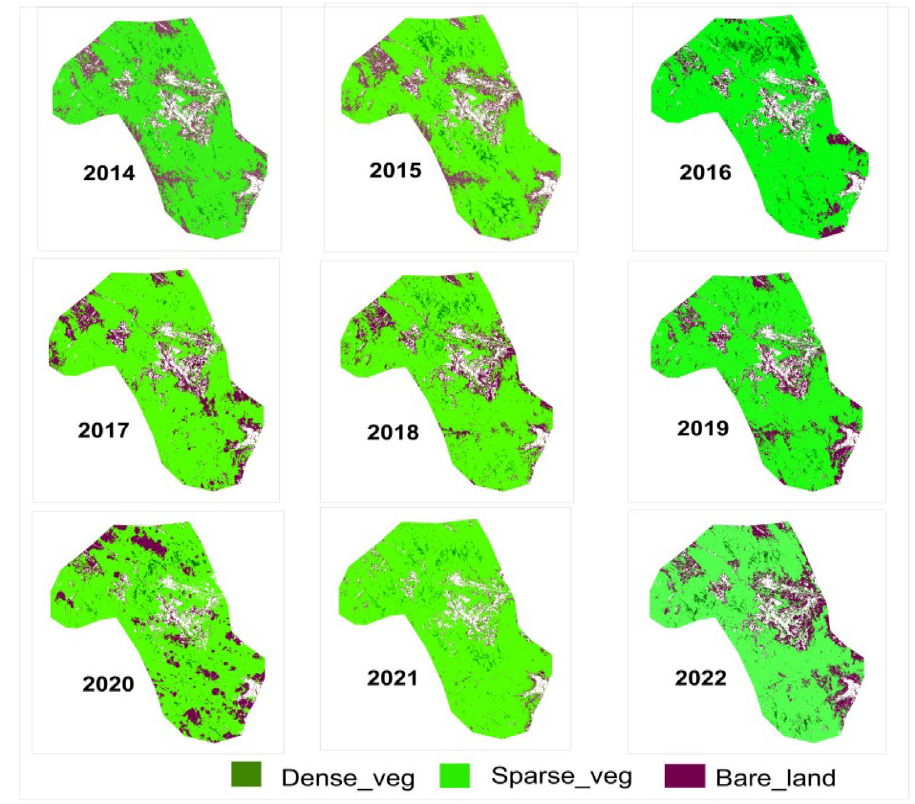
Fig. 5 Map of forest cover change